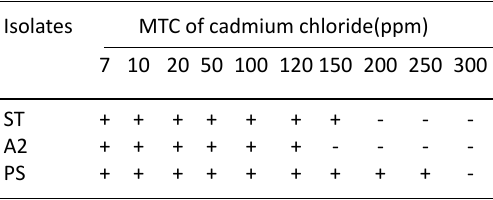
Table 2. Maximum Tolerable Concentration of Lead Nitrate (ppm):